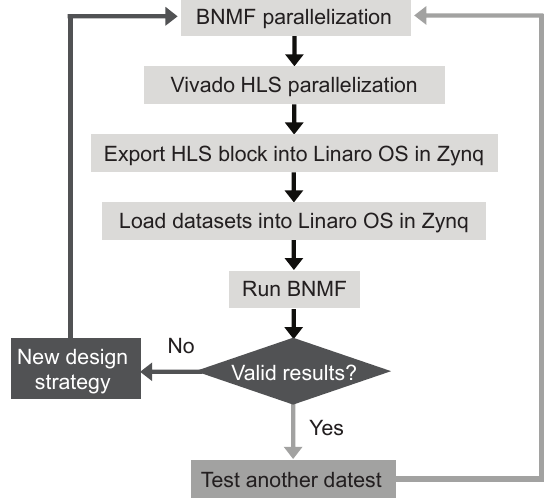
Figure 5. Experimental